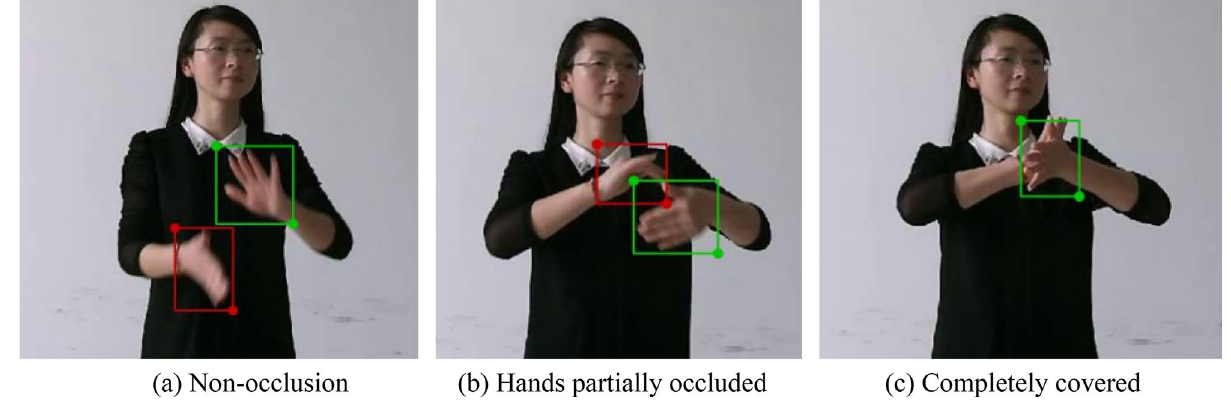
Figure 15. Schematic diagram of annotation